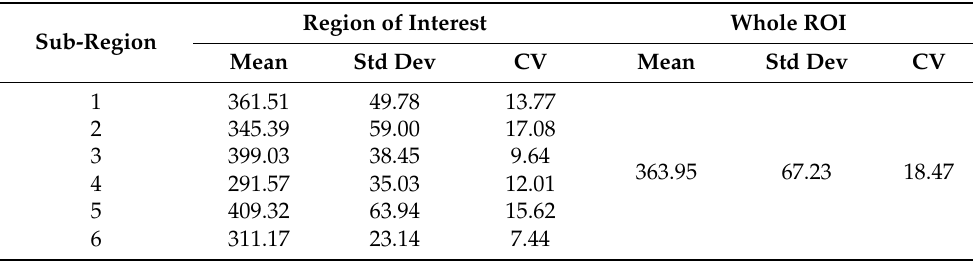
Table 4. Extreme rainfall statistics of six sub-regions within region of interest and the whole region of